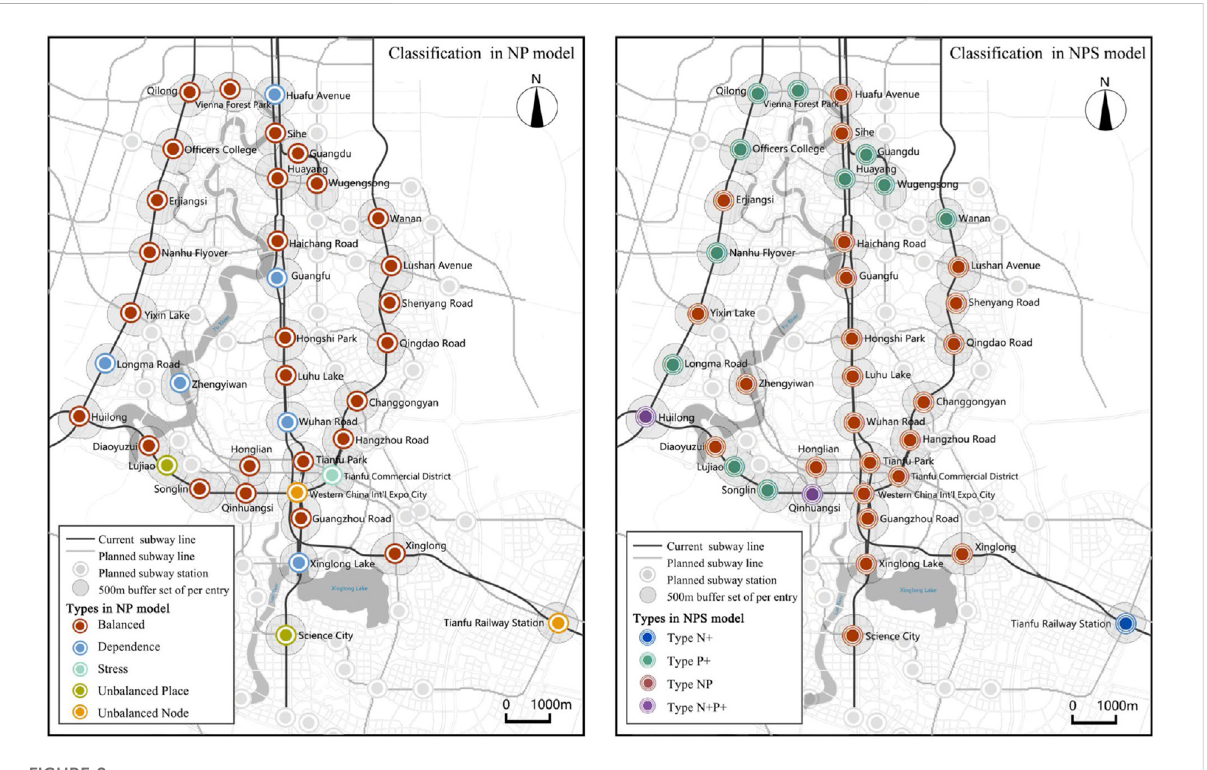
FIGURE 8 Results of metro stations in the NP model and the NPS